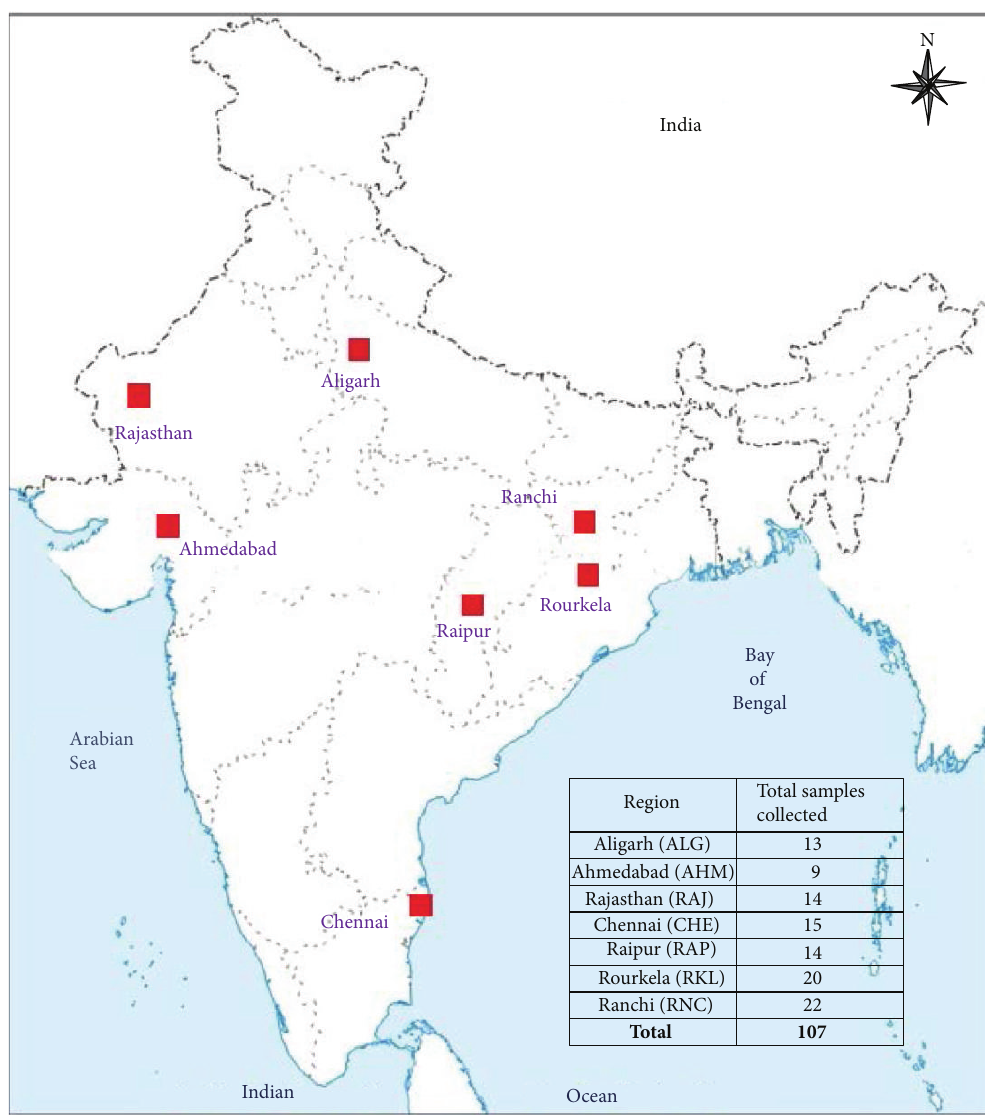
Figure 1: Map of India showing different regions from where malaria symptomatic samples were collected. The table specifies the number of samples collected from each